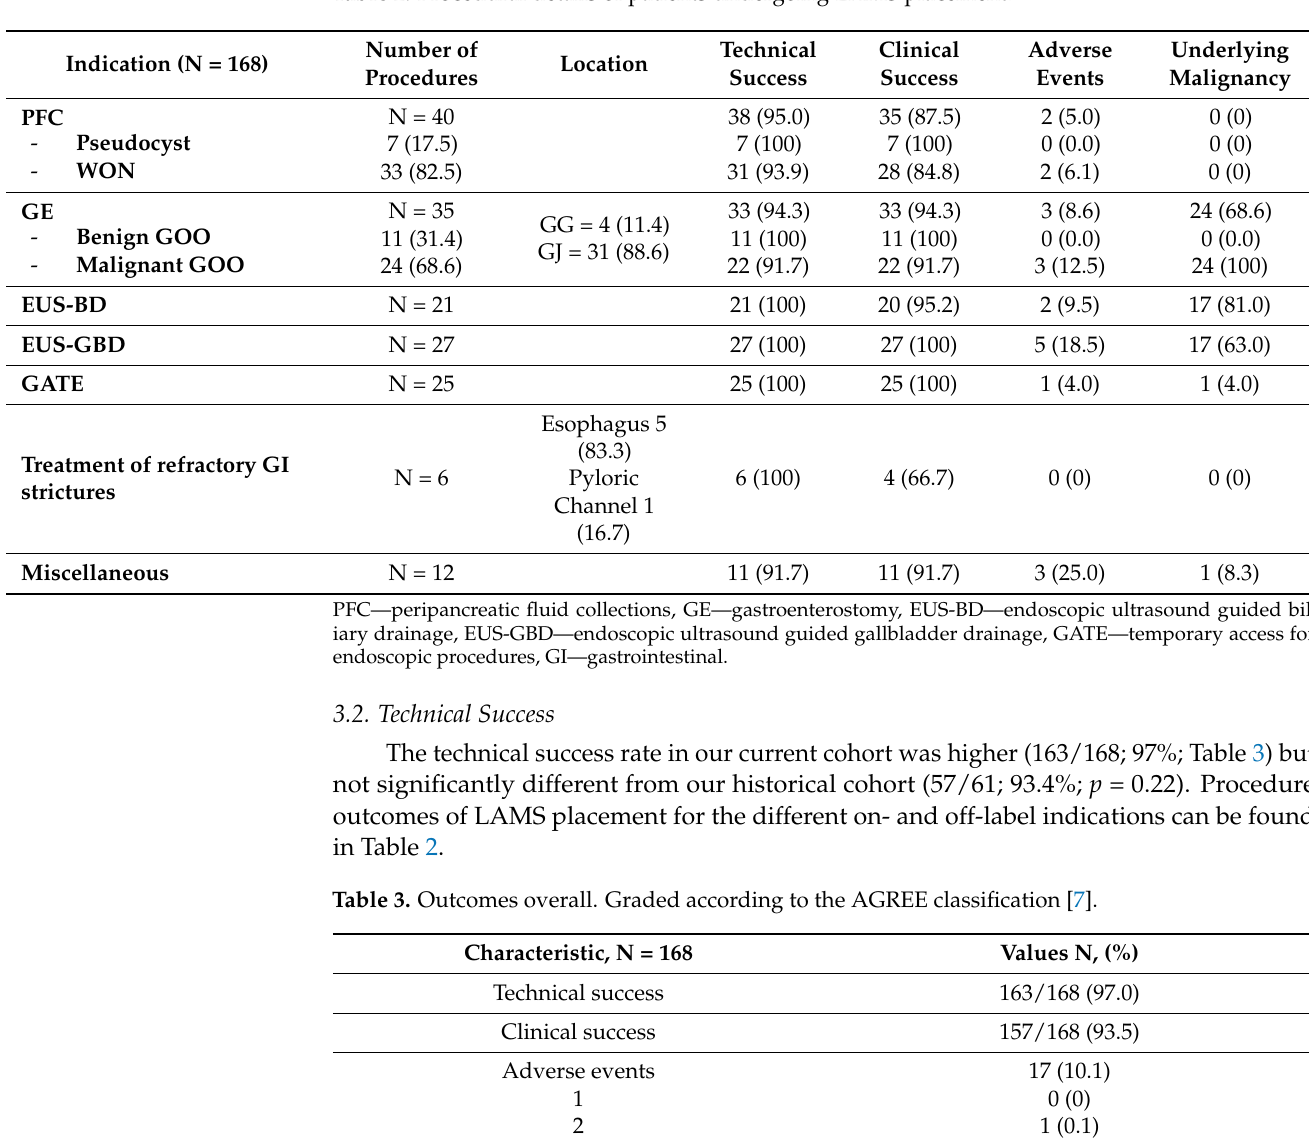
Table 2. Procedural details of patients undergoing LAMS placement.